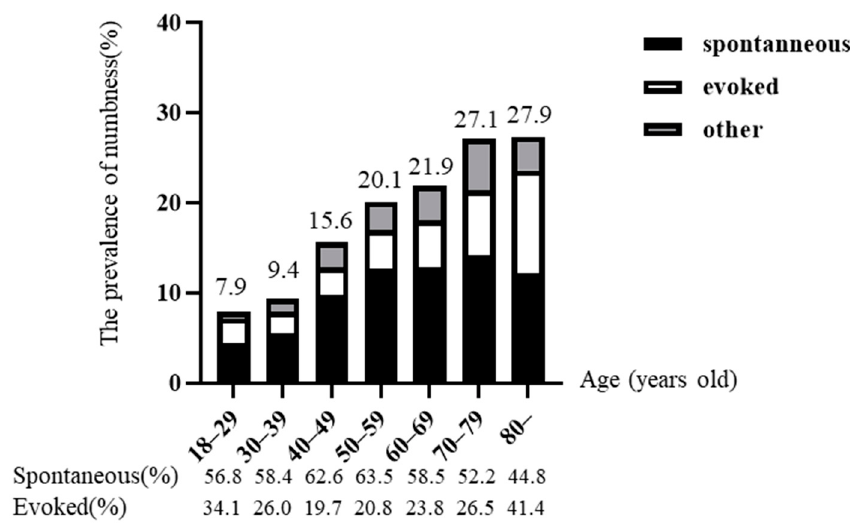
Figure A1. The relationship was graphed with age on the horizontal axis and prevalence on the vertical axis. The bars indicate the percentage of each type of numbness (spontaneous, evoked, and other). Table A1. Diseases causing numbness and their rates.